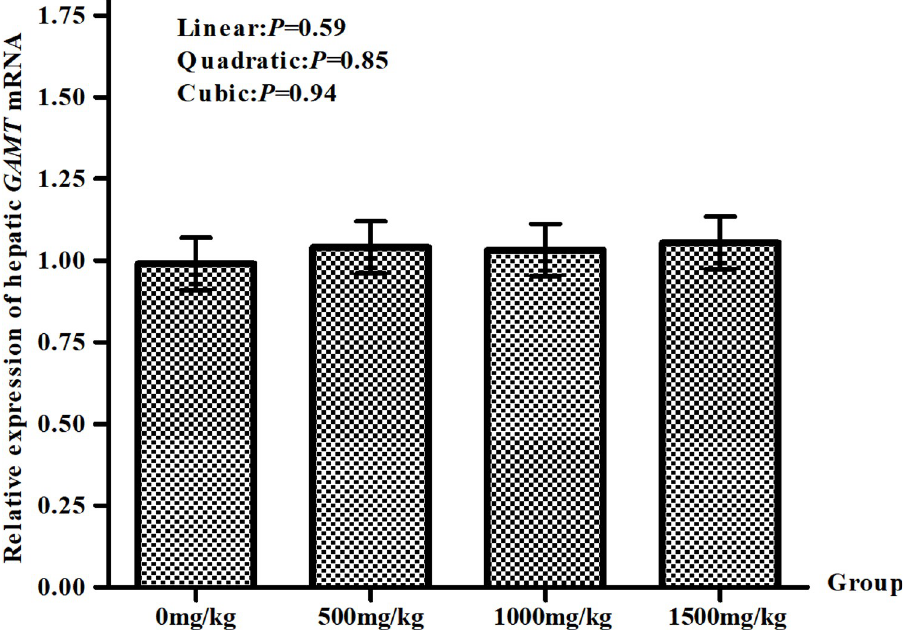
Fig 1. The mRNA expression of GAMT in lambs liver. The mRNA expression of GAMT in lambs live following a diet supplemented with 500, 1000, 1500 mg/kg DM GAA or no supplementation at 4 h after feeding. Values are least squares means ± SE ( n = 5 lambs/group). The results were presented as least squares means and standard error (SE), with P < 0.05 indicating the effects are